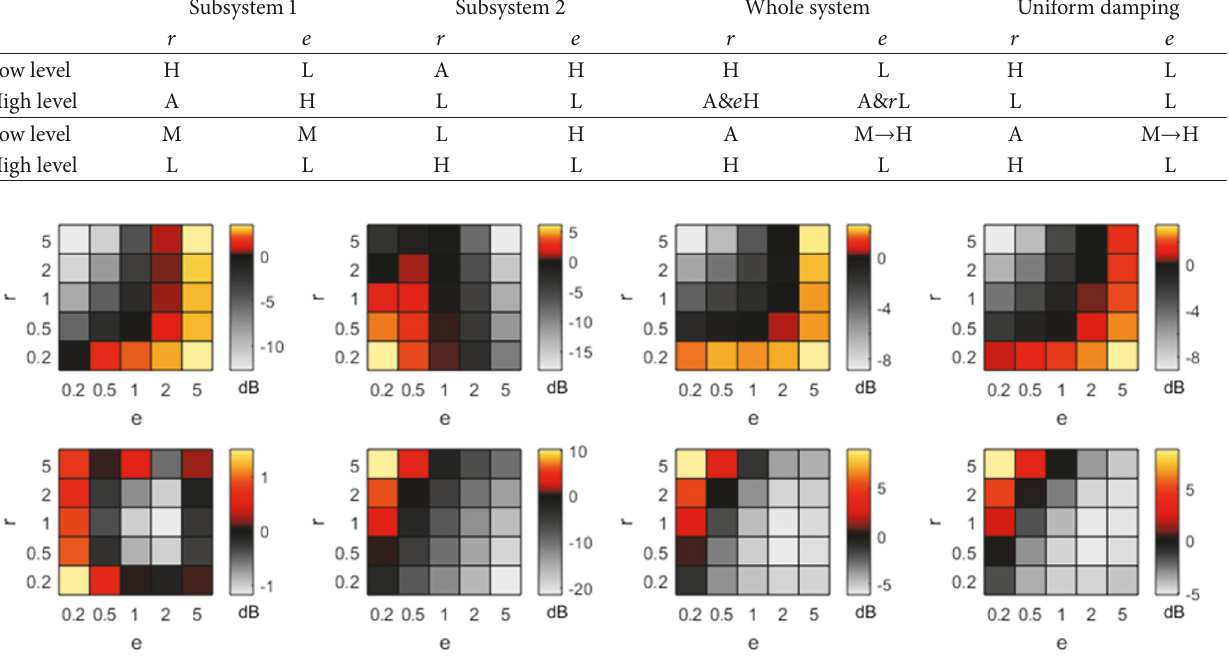
Figure 3: Normalised damping-averaged kinetic energy in dependence of resistance and eigenvalue ratios.